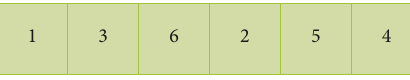
Figure 1: Genotype